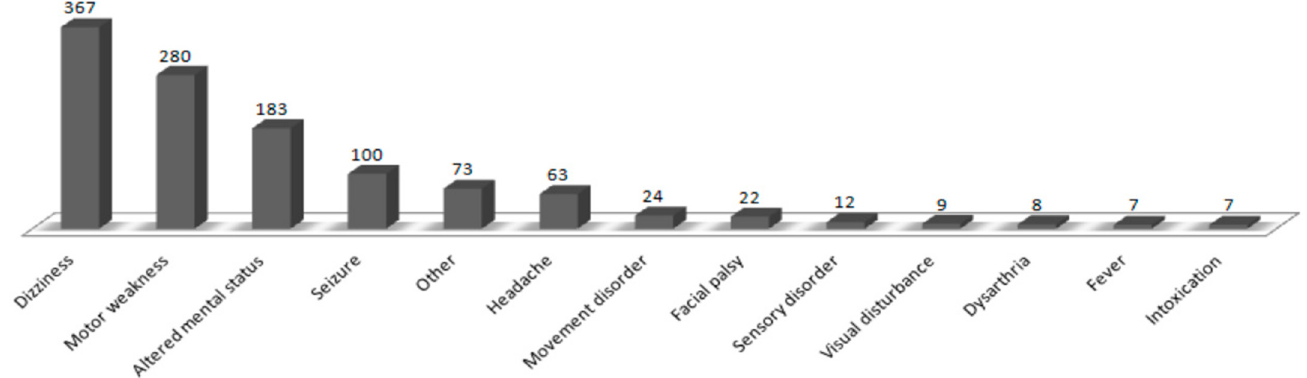
Figure 3. Chief complaints of the enrolled patients.